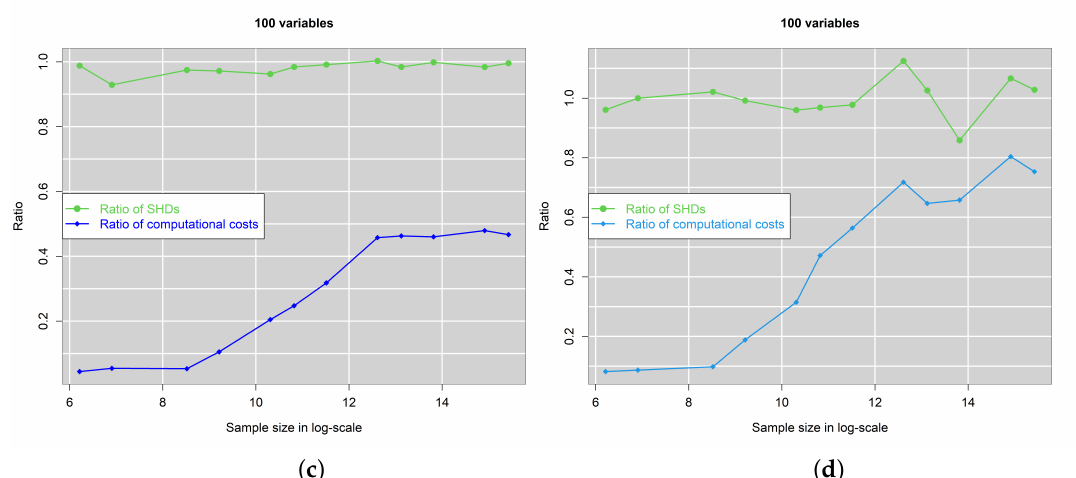
Figure 7. Ratios of SHD and computational cost against log of sample size for various dimensions, with 3 neighbours and 5 neighbours on average. The ratios depict the errors and computational cost of the raw FEDHC relative to the robustified FEDHC with NO outliers. ( a , c ) 3 neighbours. ( b , d ) 5 neighbours.